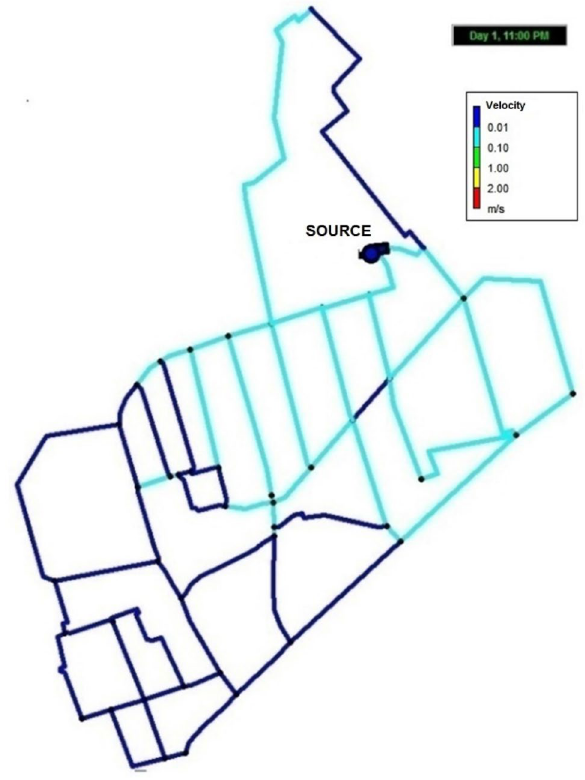
Fig. 12 Water velocity in the water supply network at the time of the lowest